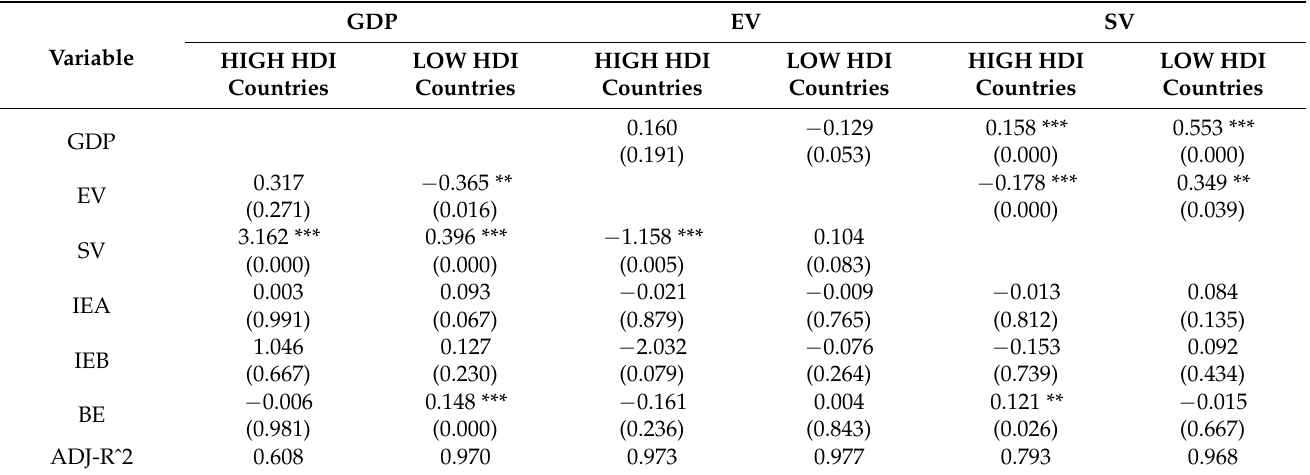
Table 7. Heterogeneity